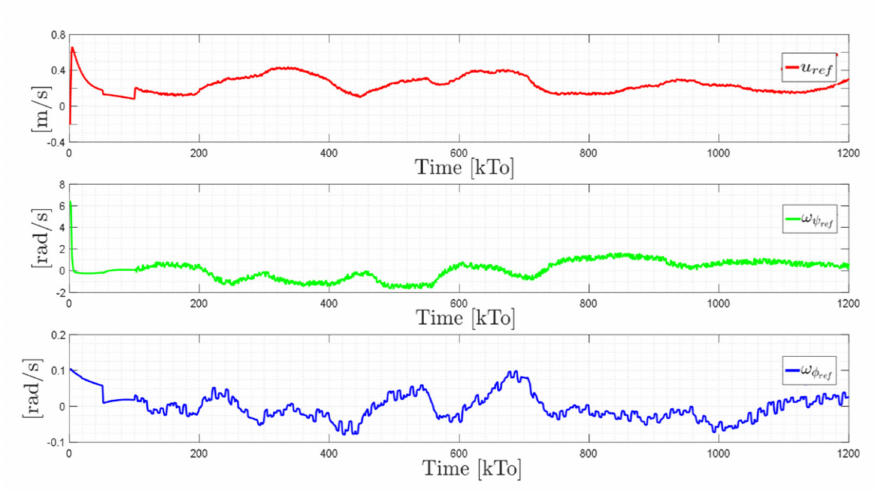
Figure 31. Velocity commands to the standing wheelchair µ ref ( kT 0 ) = ( µ x , ω ψ